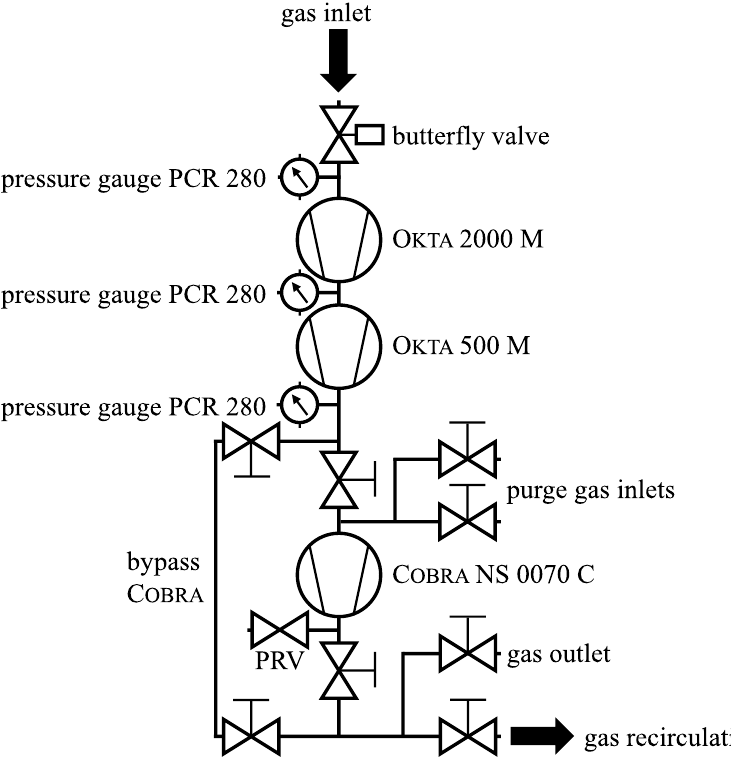
Figure 3. Vacuum scheme of the rotary lobe pump station. PRV: pressure relieve valve. Adapted from Ref. [86], licensed under CC BY-NC-ND 4.0.